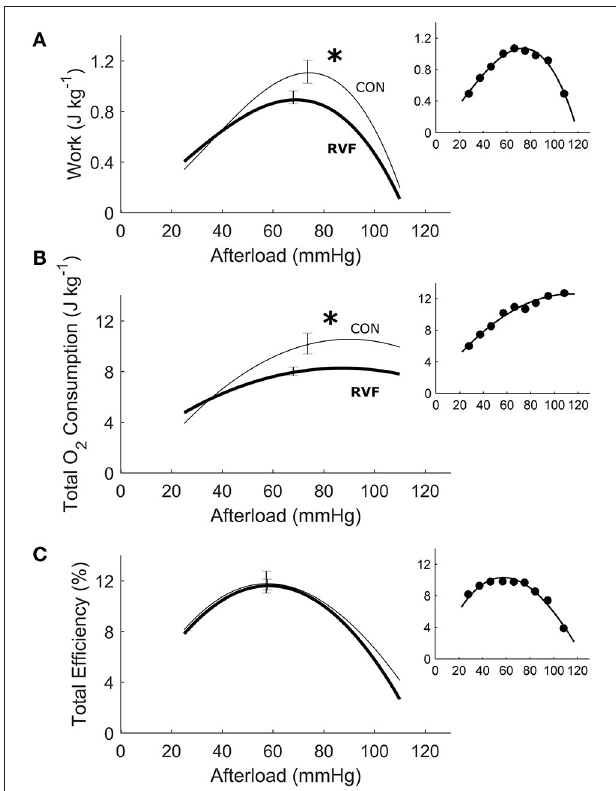
FIGURE 4 | Energetics of ex vivo left ventricles of hearts from control and right-ventricular failing rats. The two rat groups have the same total efficiency over a wide range of afterloads (C) , given that the average reduction in mechanical work (A) in the RVF hearts was offset by a comparable reduction in total oxygen consumption (B) . Asterisks indicate statistical significant differences between groups. All insets display data obtained from the same representative heart as shown in Figure 3